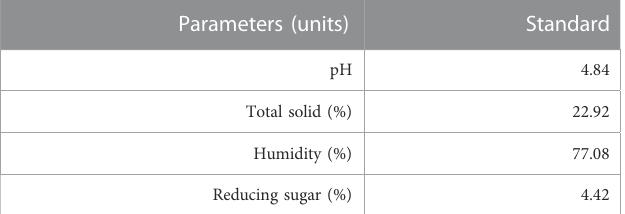
TABLE 1 Classi fi cation scheme to consistently spot similar peel features for oil extraction experiments.